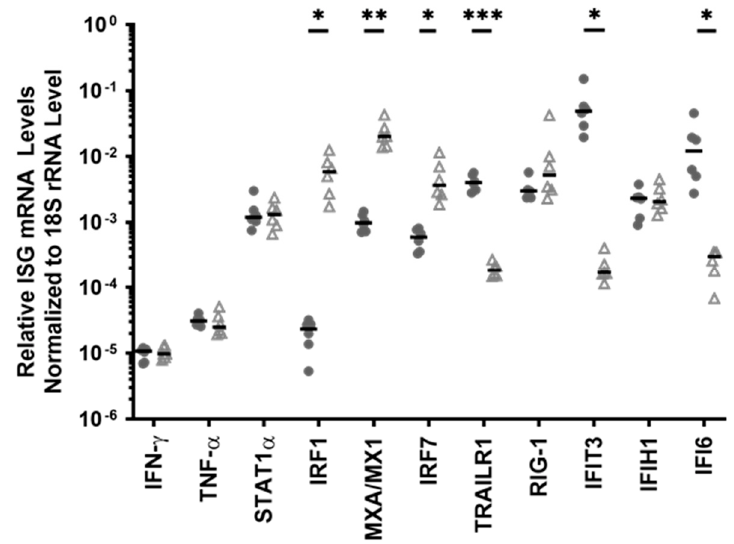
Figure 7. A modest reduction in IRF-1 expression altered the ISG expression profile in unstimulated primary CD4+ T cells from the non-HESN controls. Ex vivo CD4+ T cells were treated with IRF-1 specific ( • ), or control siRNA ( (cid:52) ) aptamer chimera (8 nM) that enters cells via binding to cell surface CD4 molecule. At 24 h, the efficiency of RNA knockdown was assessed using flow cytometry and ISG RNA transcript levels in the CD4+ T cells were quantitated using RT-qPCR. All relative expression values were normalized to the corresponding 18S rRNA. ( n = 6 per group). Median values ( - ) were shown for each group. * p -value < 0.05; ** p -value < 0.01, *** p -value < 0.001; n.s. denotes